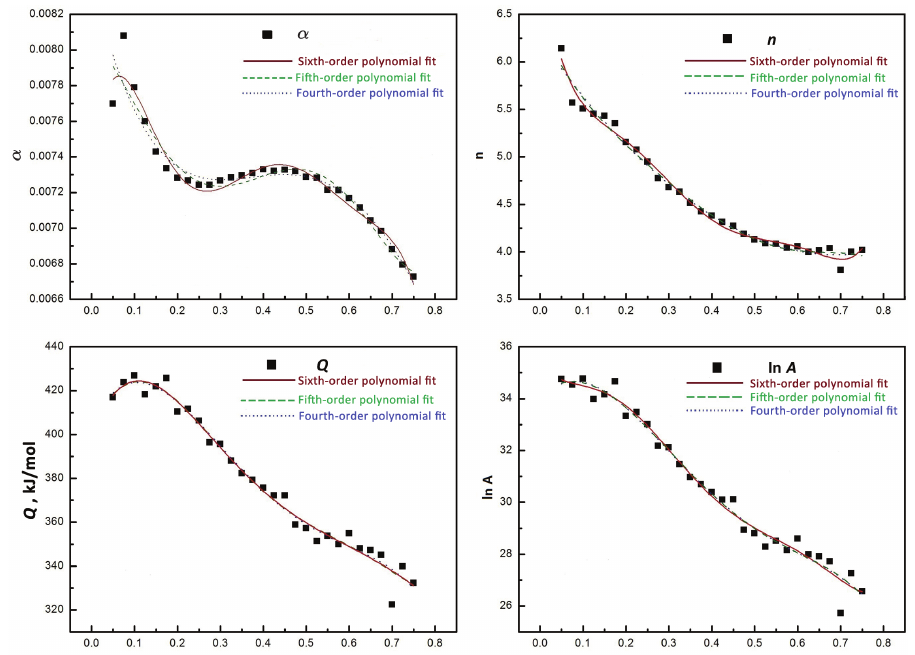
Figure 7: Relationships between material constants ( α , n , Q and ln A ) and true strain using polynomial